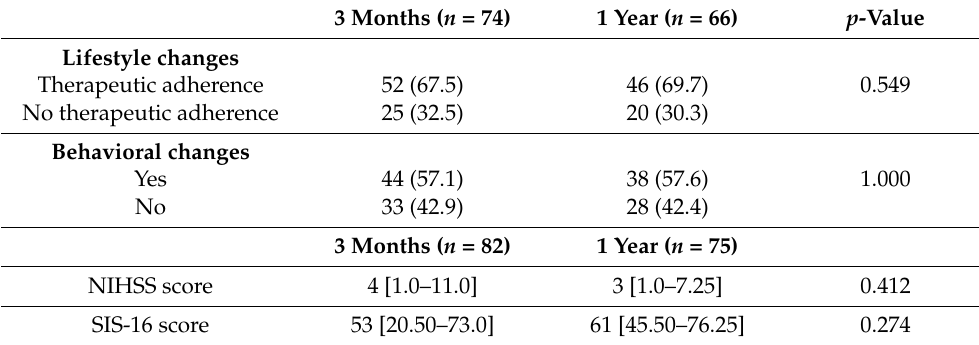
Table 2. Healthy lifestyles in patients through therapeutic adherence, behavioral changes, NIHSS, and SIS-16 scores at 3 months and 1 year after stroke.